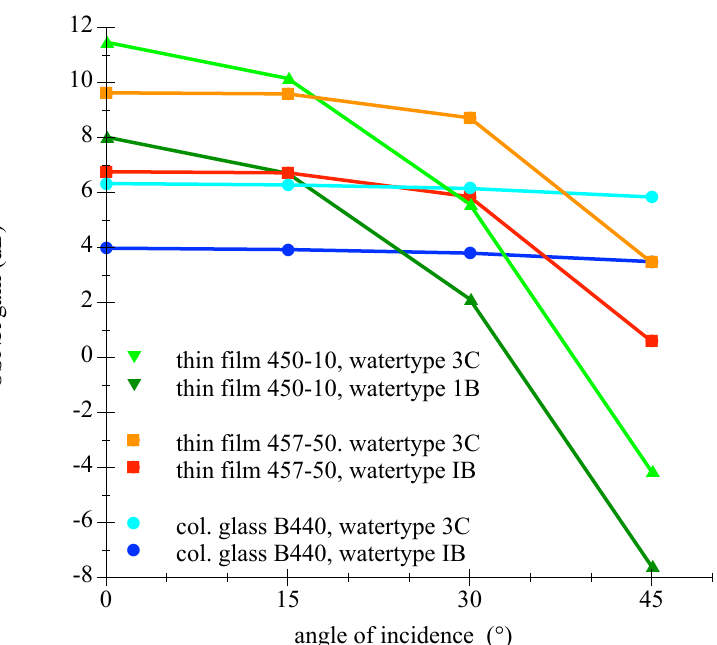
Figure 18. Graphics is showing the change in OSNR as function of the AOI for three different filters at 5 m depth in water types IB (clear ocean) and 3C (coastal